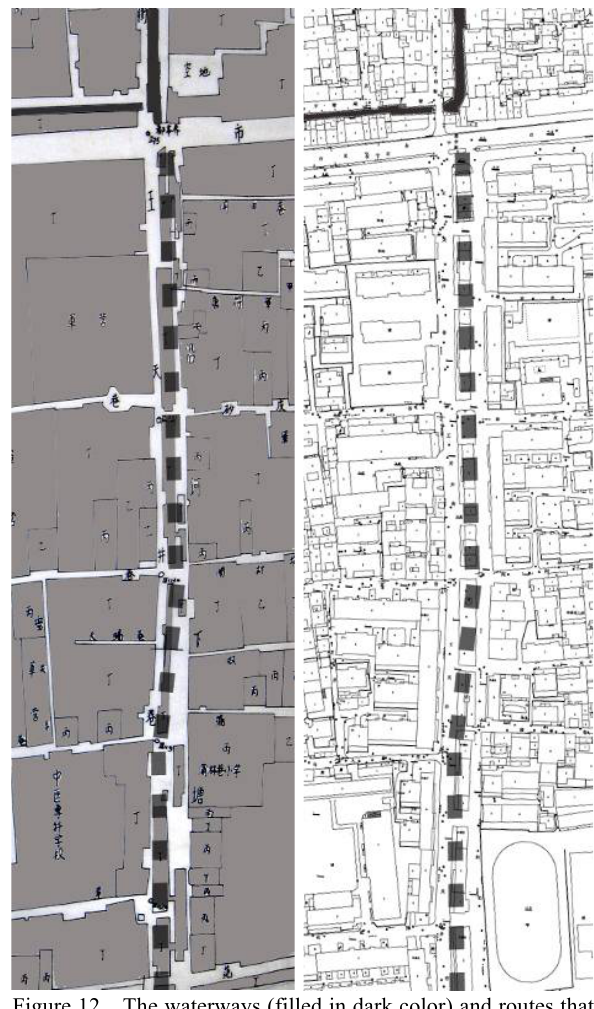
Figure 12 ． The waterways (filled in dark color) and routes that used to be waterways (dashed line) at the Wangtianjinxiang alley ( 王天井巷 ) in 1:2000 map of 1958 and 1:500 map of 1990’s. It used to be the 2 nd Longitudinal canal, where in the